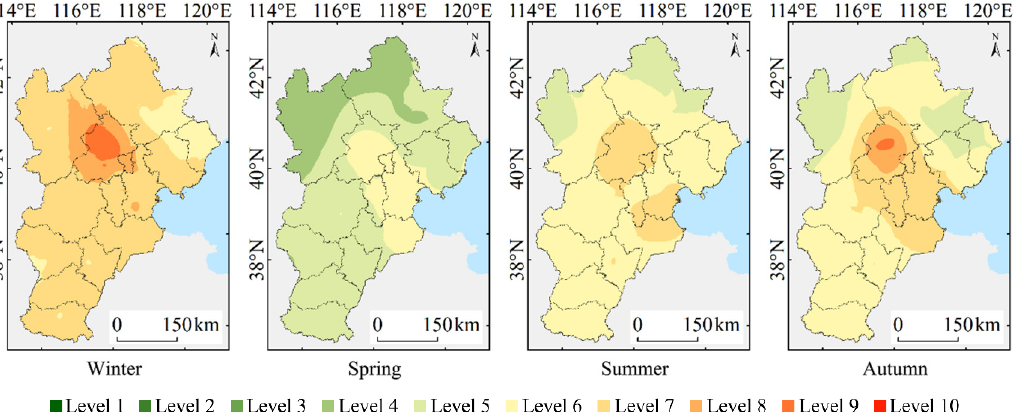
Figure 7. Spatial distribution of the seasonal mean value of the PM 2.5 /PM 10 ratio.